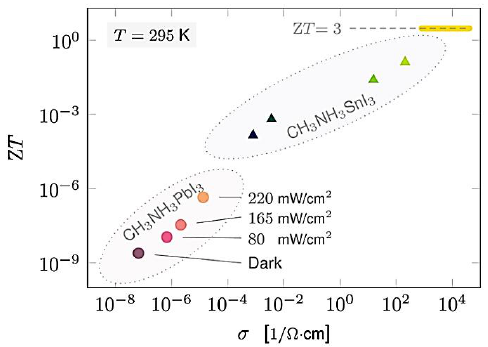
Figure 14. ZT of CH 3 NH 3 PbI 3 and CH 3 NH 3 SnI 3 at 295 K, with doping, monitored through the conductivity increase with photo and impurity doping. Red, orange, and yellow correspond to light intensities of 80, 165, and 220 mW·cm −2 . The dashed line marks ZT = 3. Adapted with permission [160]. Copyright 2015, American Chemical Society.